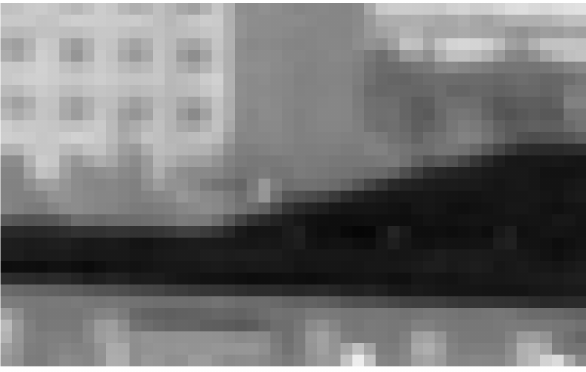
Figure 16. Target fusion with a dark